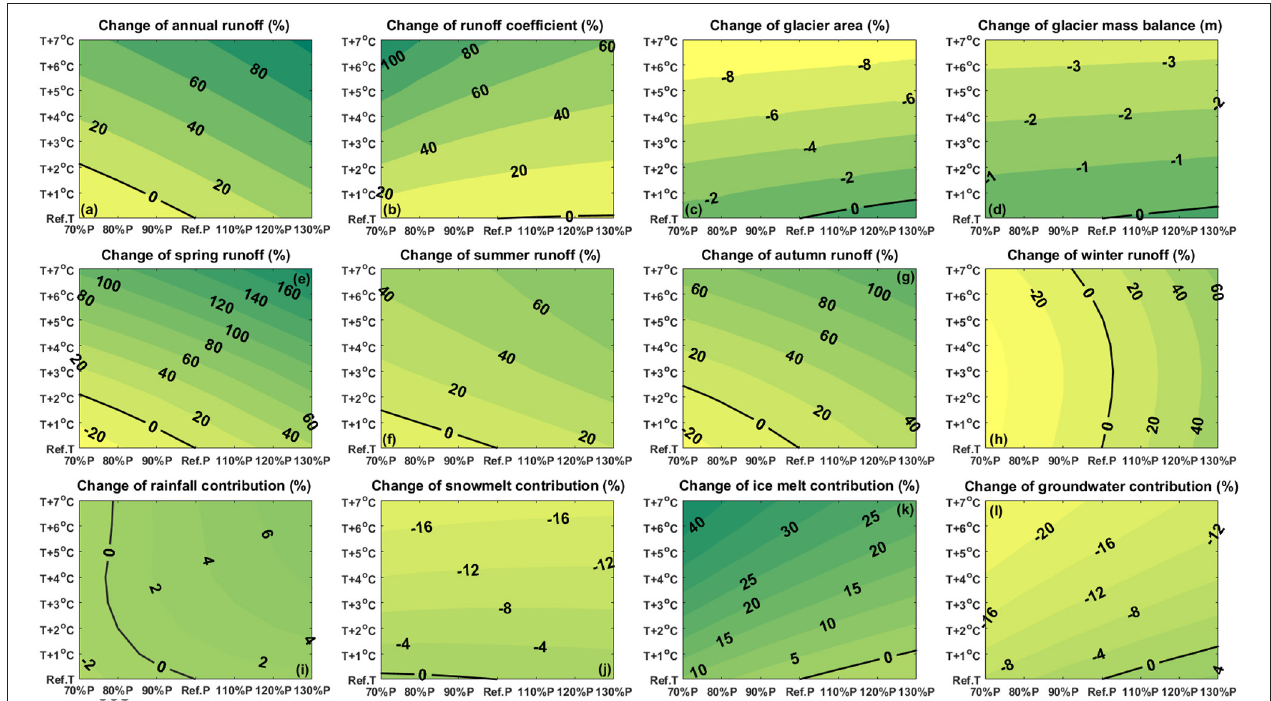
FIGURE 9 | Compensation effects of temperature warming and precipitation changes on hydrological